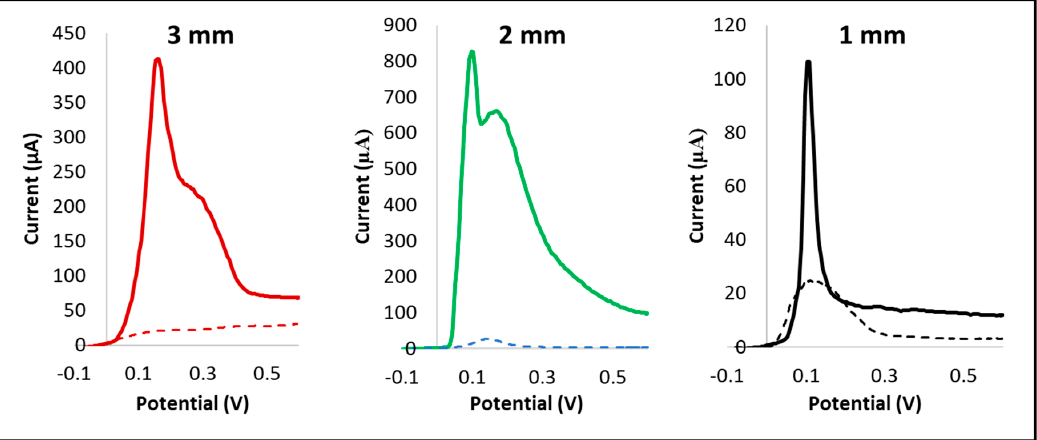
Figure 6. Plots obtained during protein quantification test; each plot measures current (expressed in µA) as a function of potential (expressed in V). Dotted lines represent “blank samples”.